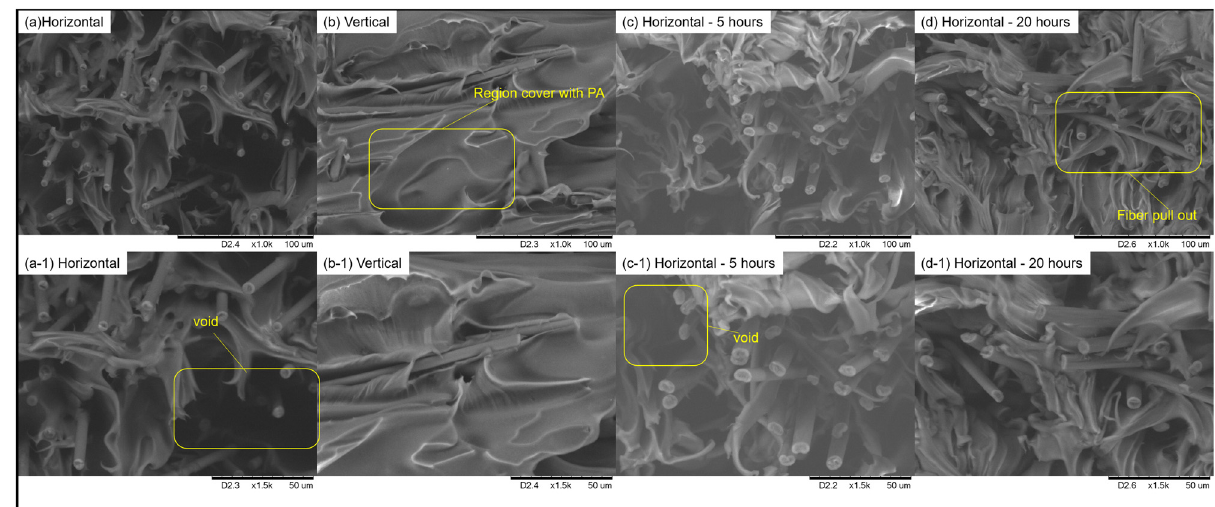
Figure 4: SEM (× 1,000 ) and (× 1,500 ) of PACF composites: direction of ( a ) horizontal and ( b ) vertical; dried for ( c ) 5 h and ( d ) 20